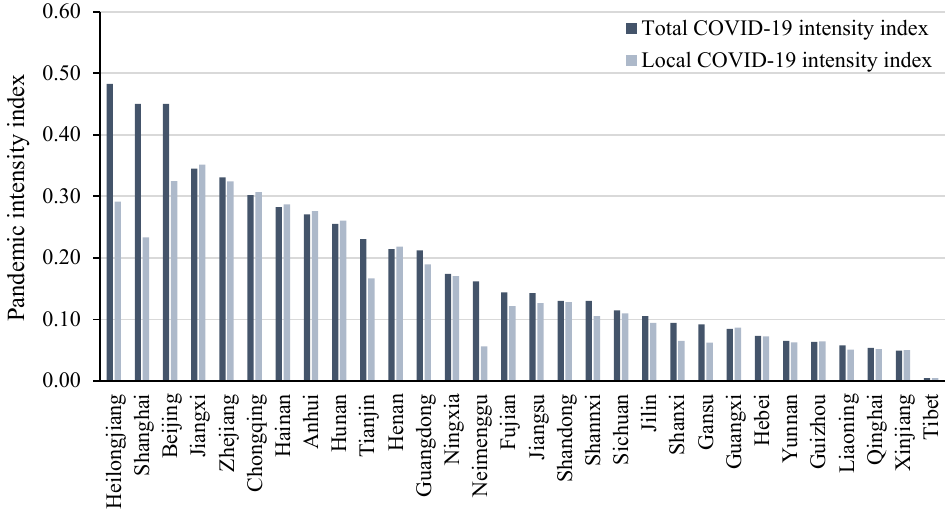
Figure 1. The cumulative numbers of COVID-19 confirmed cases in Chinese provinces as of May 2020.